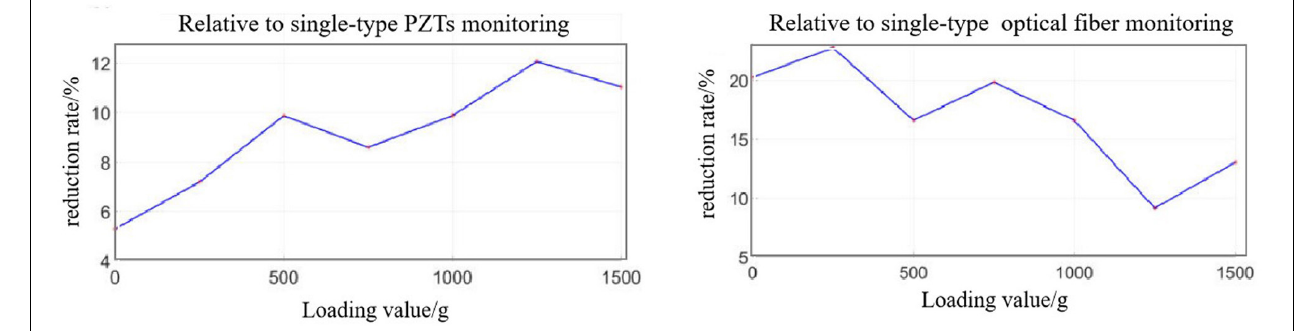
FIGURE 13 | The location error reduction rate of the two-stage fusion relative to single-type PZTs and single-type optical fiber sensor monitoring.